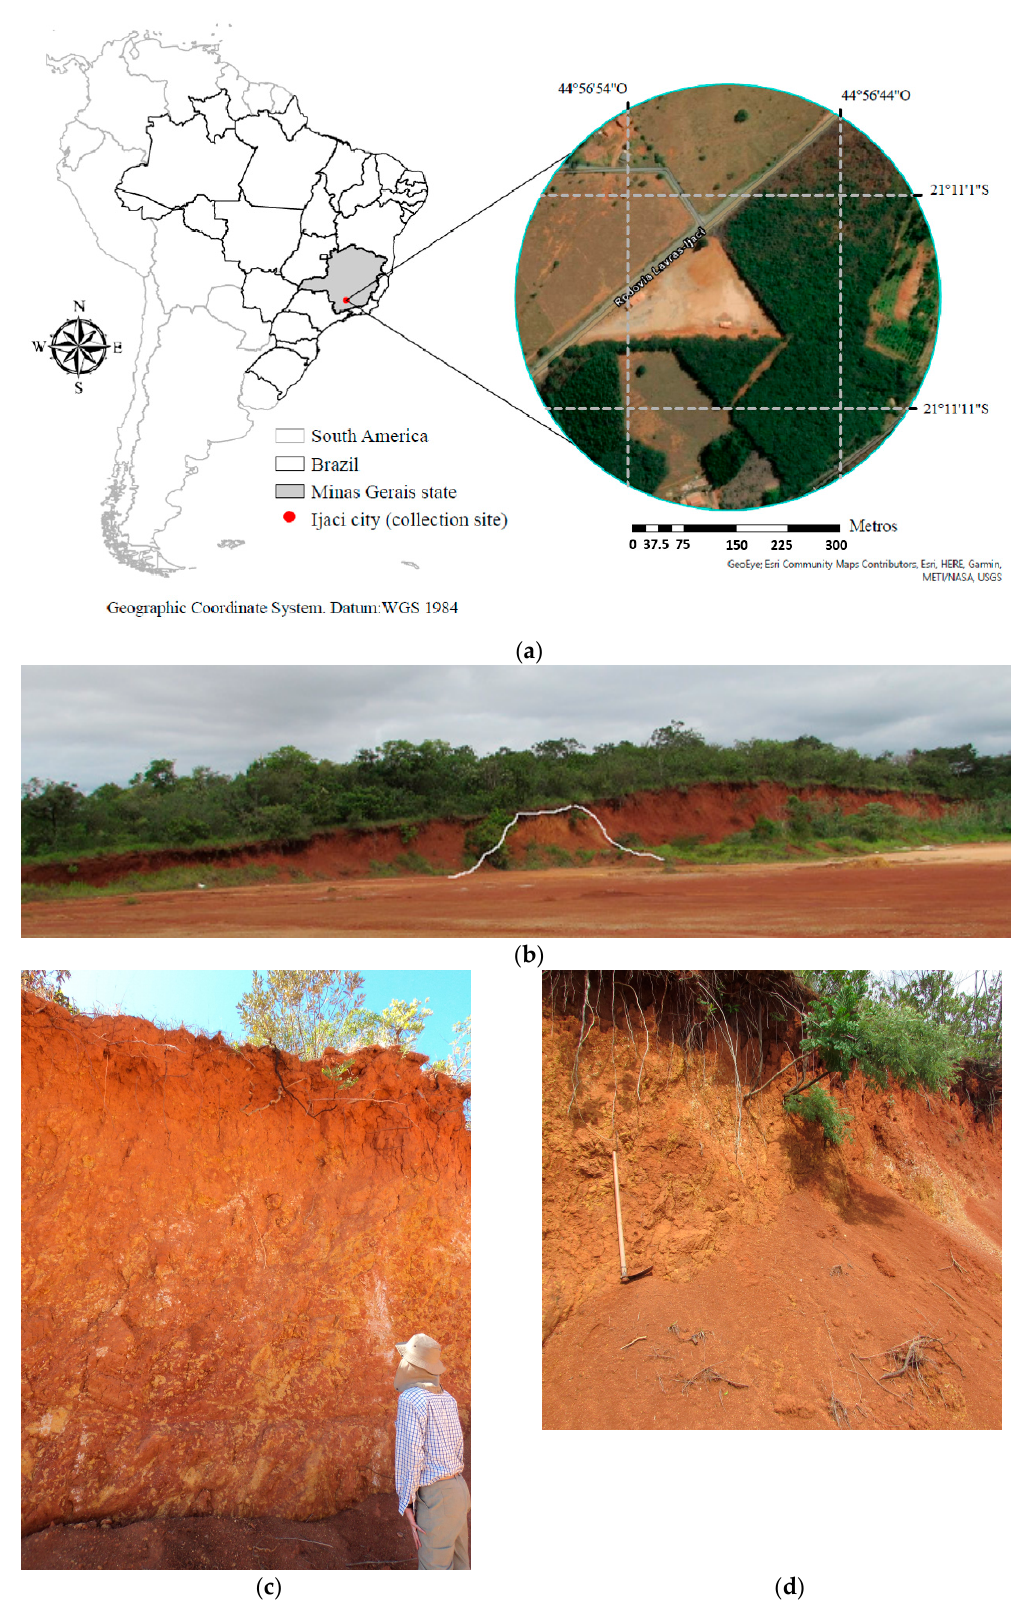
Figure 1. ( a ) Map with location of study site and the triangular-shaped mechanized cut from the air; ( b ) ground view showing the hill-shaped mottling intersecting non-conformably the red Oxisol and land surface; ( c ) red–yellow mottling; and ( d ) mostly deferrified, white–yellow mottling. Note the deferrified, mostly white colors of the white–yellow mottled section on the right corners of ( a , b , d